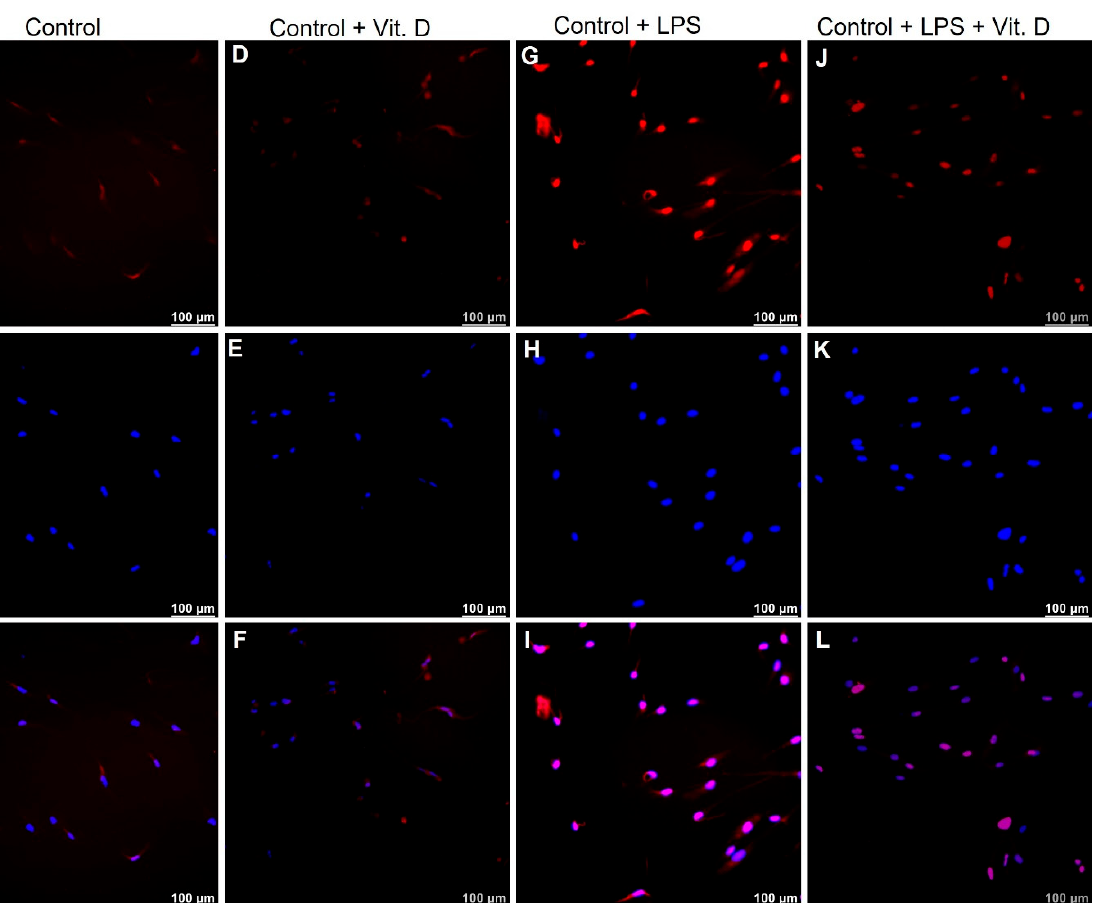
Figure 5. Immunofluorescence for IL-33 in endothelial cells (ECs). Immunofluorescence for IL-33 in control (panel A ), calcitriol treated ECs (panel D ), lipopolysaccharide (LPS) treated ECs (panel G ), and calcitriol + LPS treated ECs (panel J ); 4 ′ ,6-diamidino-2-phenylindole (DAPI, panels B , E , H , and K ); merged images (panels C , F , I , and L ).